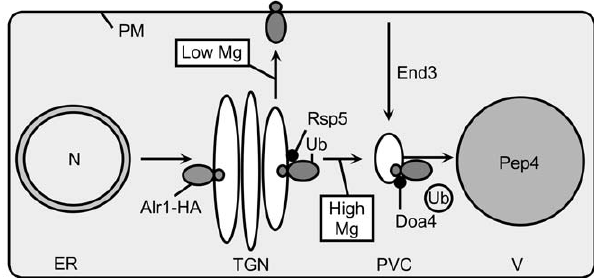
Figure 6. Proposed model for Mg-dependent trafficking of Alr1-HA. After synthesis, fate of the Alr1-HA protein is dependent on Mg supply. In Mg-deficient cells, more Alr1-HA escapes an Rsp5- dependent quality control mechanism and reaches the plasma membrane, where it is not subject to Mg-stimulated endocytosis. In replete conditions, Alr1-HA is recognized by Rsp5, ubiquitinated, and sorted to the PVC, where it is intercepted by Doa4 and sorted to the vacuole lumen for eventual Pep4-dependent degradation.